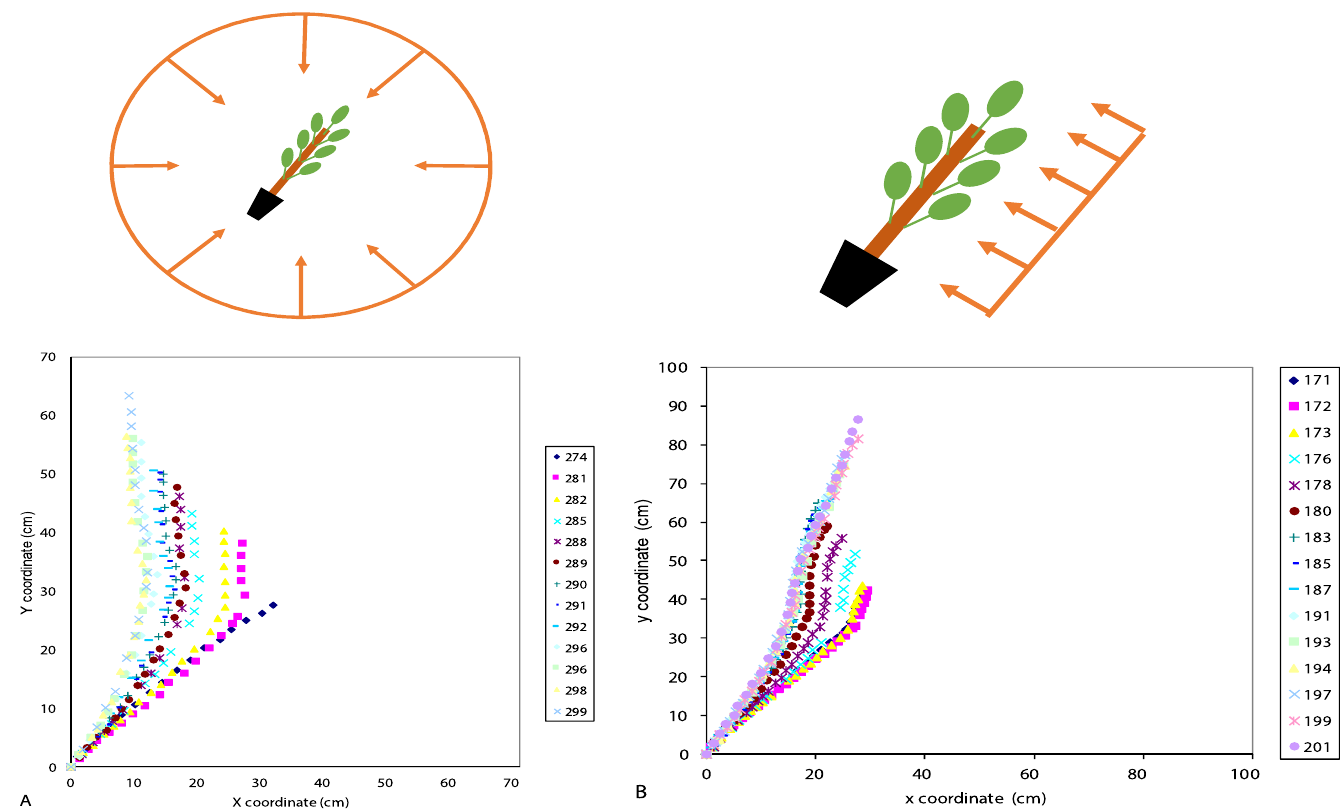
Fig 4. Successive shapes of poplar stems subjected to tilting in an isotropic light environment or in an anisotropic light environment. A: Isotropic light environment: the stem tends to be vertical at steady state. B: Anisotropic light environment: the stem remains inclined at steady state.